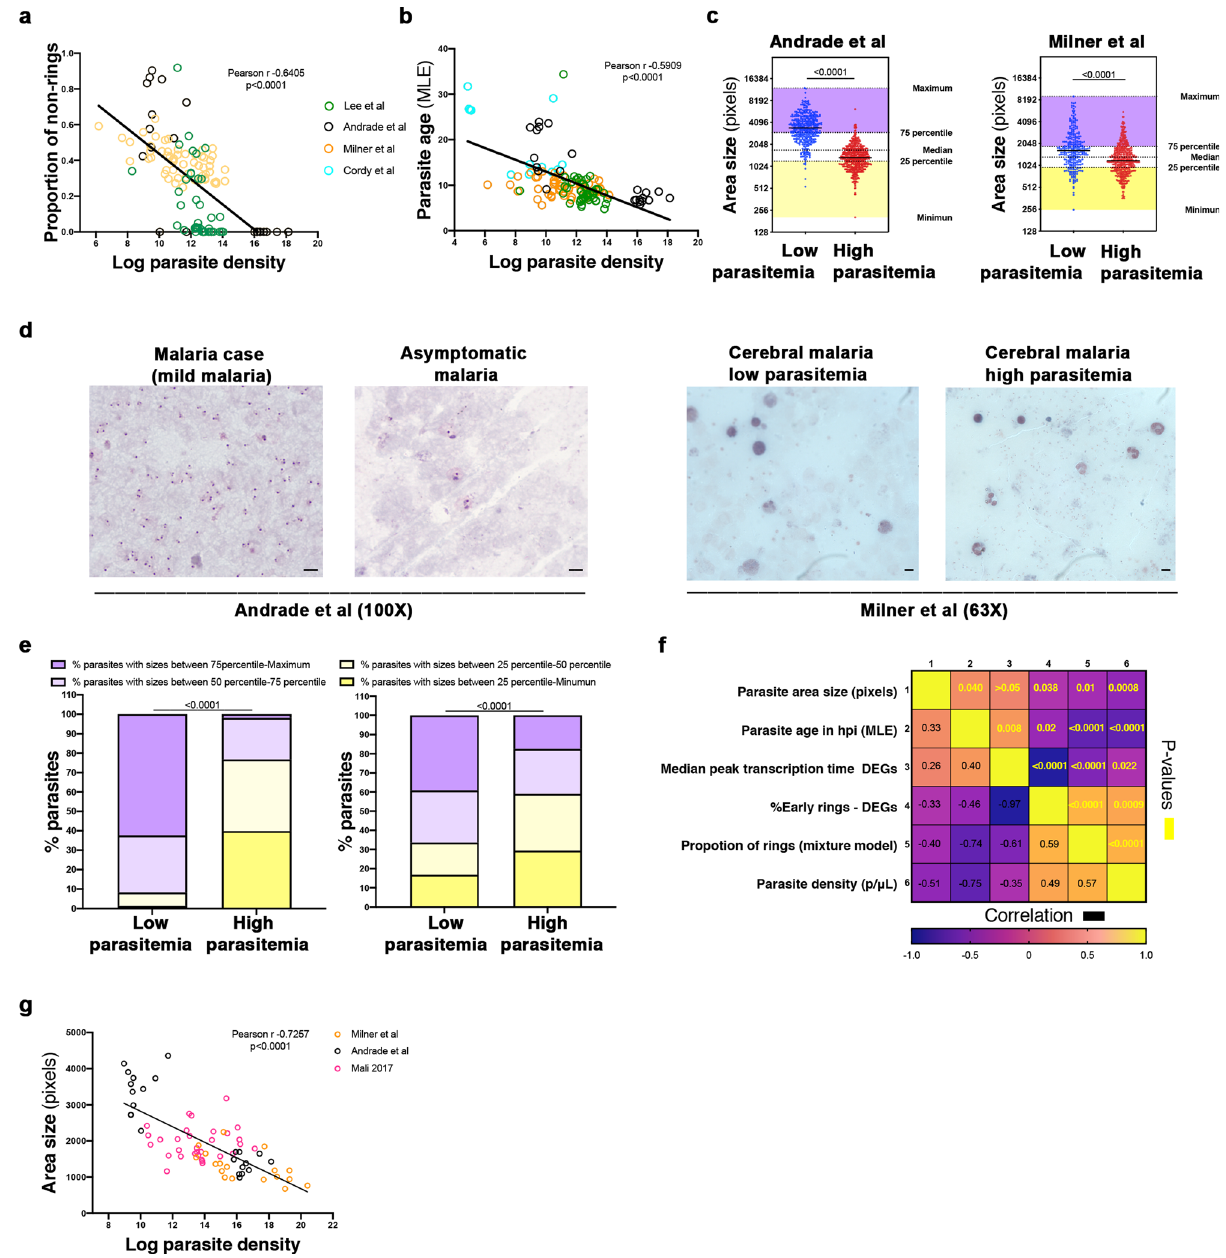
Fig. 5 Infected erythrocytes circulate longer in low than in high parasitaemias. a Correlation between parasite density and estimated proportion of non- ring stages according to Tonkin-Hill et al. 17 of all samples in Andrade et al. (black), Milner et al. (orange), Lee et al. (green). p and r determined by Pearson correlation. b Correlation between parasite density and average parasite age by MLE in hours post invasion estimated according to Lemieux et al. 16 of all samples in Andrade et al. (black), Milner et al. (orange), Lee et al. (green), and Cordy et al. (light blue). p and r determined by Pearson correlation. c P. falciparum area measured from thick smears in low parasitaemia samples (blue) in Andrade et al. and Milner et al., and in high parasitaemia samples (red) of the same studies. Yellow and purple shaded regions indicate 1st and 4th quartiles highlighting smallest and largest parasite sizes, respectively. Data indicate median ± IQR; two-tailed Mann – Whitney test, p < 0.0001. d P. falciparum parasites in thick blood fi lms collected straight from the arm of children with low parasitaemia samples (left) in Andrade et al. and Milner et al., and high parasitaemia samples (right) of the same studies. Data show measurements of one of 3 – 4 independent readers blinded of sample grouping with interclass correlation of 0.963 and 0.889 for Malian and Malawian samples, respectively. Scale bar = 5 μ m. e Proportion in percentages of parasites imaged in thick blood fi lms collected directly from children with low and high parasitaemia samples in Andrade et al. ( n = 24) and Milner et al. ( n = 32), falling into 1st, 2nd, 3rd, and 4th quartiles. Fisher ’ s exact done over absolute values of parasites assigned to the different quartiles. f Correlation matrix of variables obtained or determined from Andrade et al. and Milner et al. The cells are colored according to the scale: yellow indicates positive correlation and purple indicates negative correlation. Correlation matrix of every variable with each other without adjustment for multiple comparisons. p values determined by Pearson correlation are highlighted in yellow. g Correlation between parasite density and parasite areas measured from thick smears in samples across a wide range of parasitaemias including Andrade et al., Milner et al., and a third study (Coulibaly et al. in preparation) with samples from uncomplicated and severe malaria cases collected in Mali. p and r determined by one-tailed Pearson